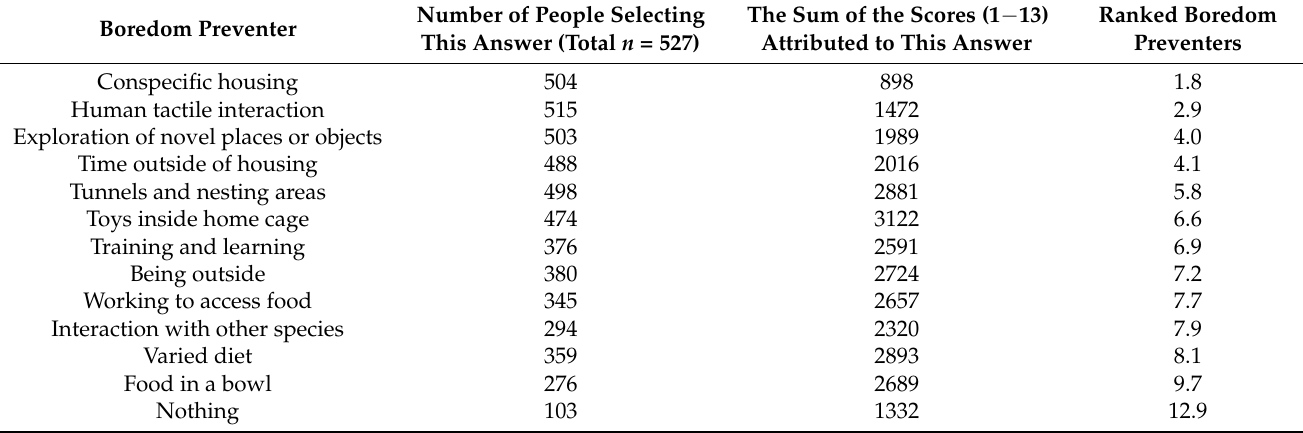
Table 5. Potential ferret boredom preventers as ranked by respondents to be most important for preventing ferret boredom (a rank of 1 for the most important to 13 for the least important). Not all boredom preventer answers were included in the ranking by all respondents. The boredom preventers are listed in order from the highest ranked (most important for preventing boredom) to the lowest ranked (least important for preventing